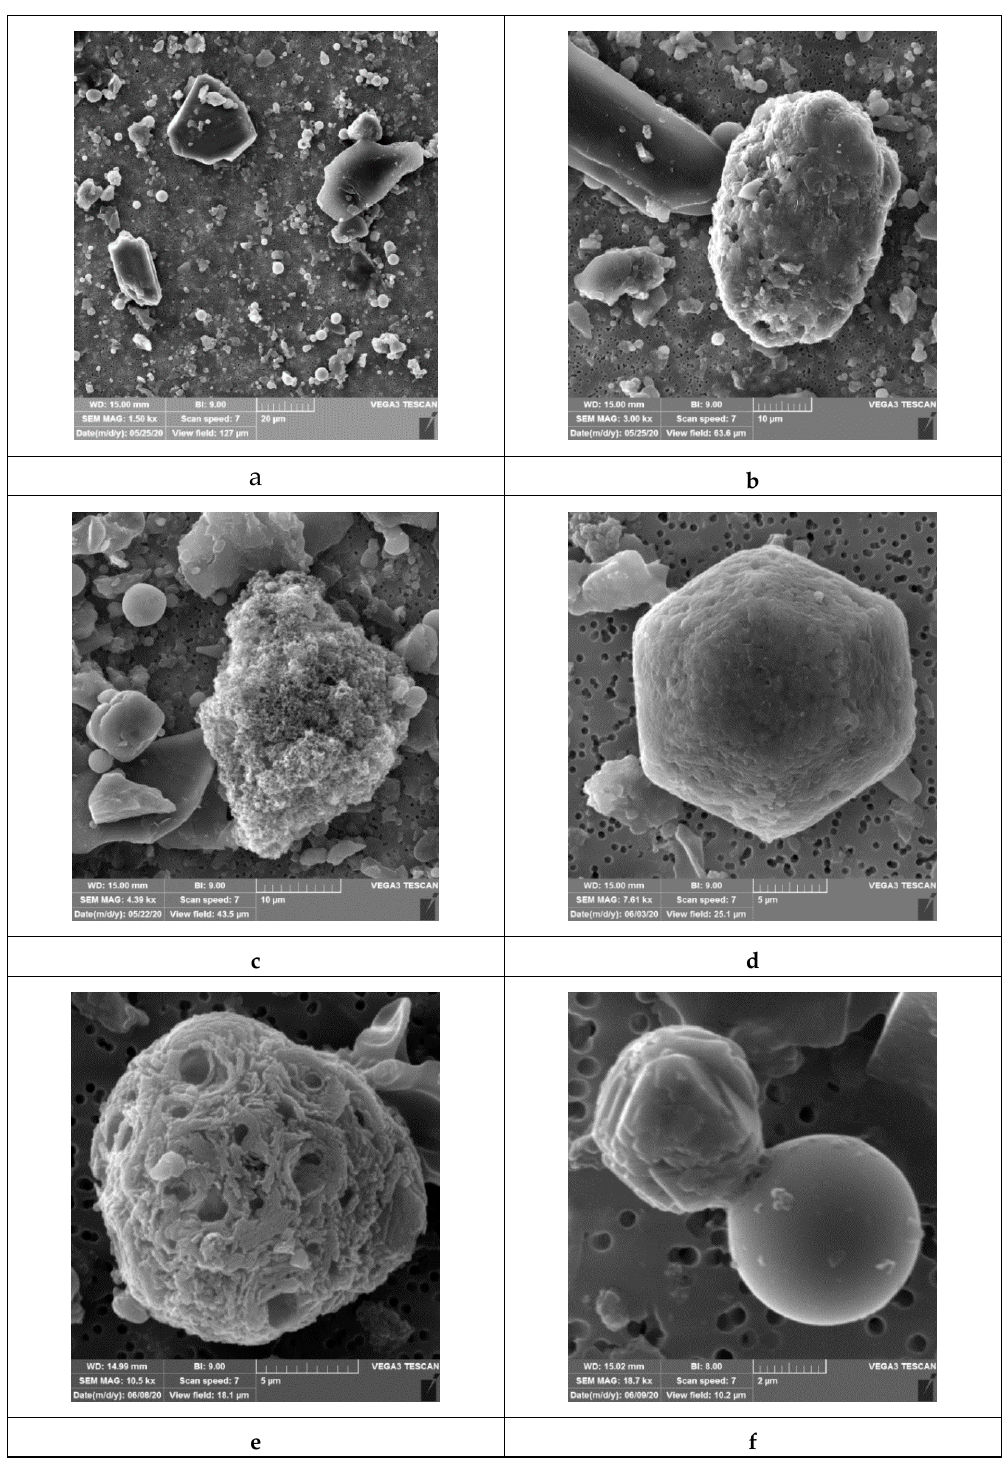
Figure 4. Typical insoluble particles in the Western Siberia snowpack: a —relatively large grains of plagioclase and smaller particles of clay minerals and ash; b —plagioclase particle with signs of intensive secondary replacement; c —black carbon particle aggregate; d —corundum microcrystal; e —porous carbonaceous ash particle; f —splice of metal slag (top) and aluminosilicate fly ash. Samples of insoluble particles at sites 1–5 are saturated with mineral particles up to 30–50 µ m in size, among which feldspars and clay particles of 4–6 µ m prevail. The proportion of quartz particles